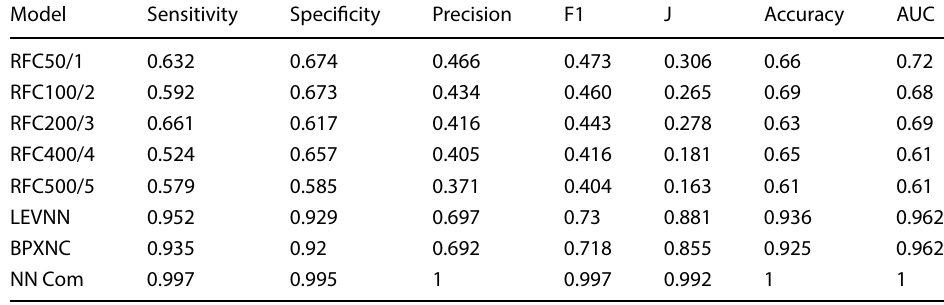
Table 12 Classification performance (training